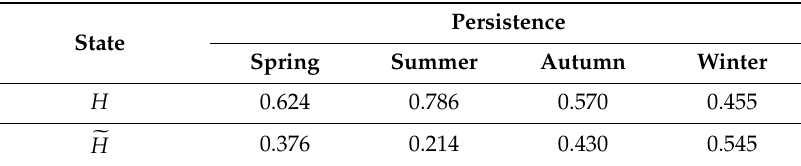
Table 8. The duration of each state under each season.